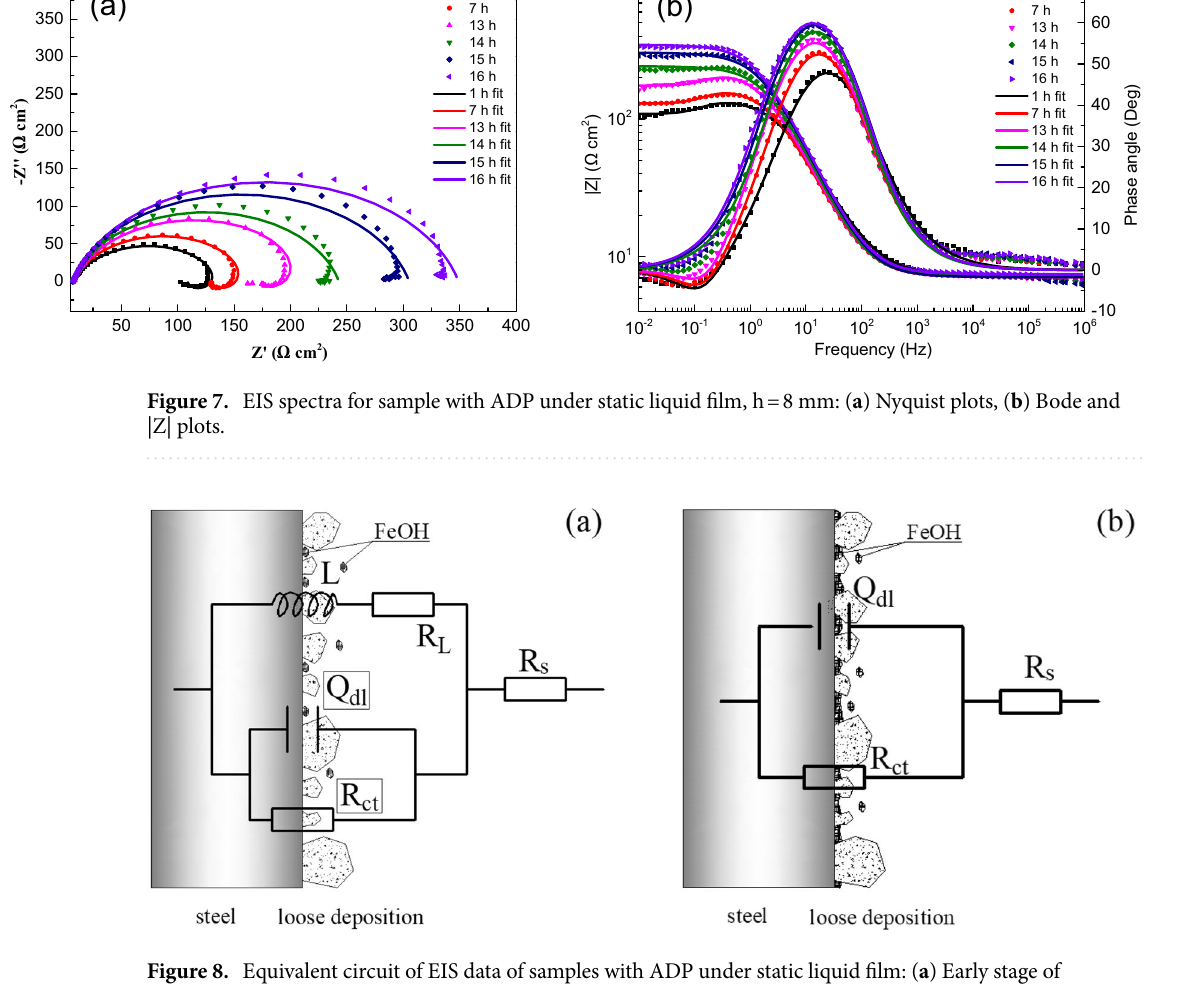
Figure 8. Equivalent circuit of EIS data of samples with ADP under static liquid film: ( a ) Early stage of corrosion, ( b ) Later stage of